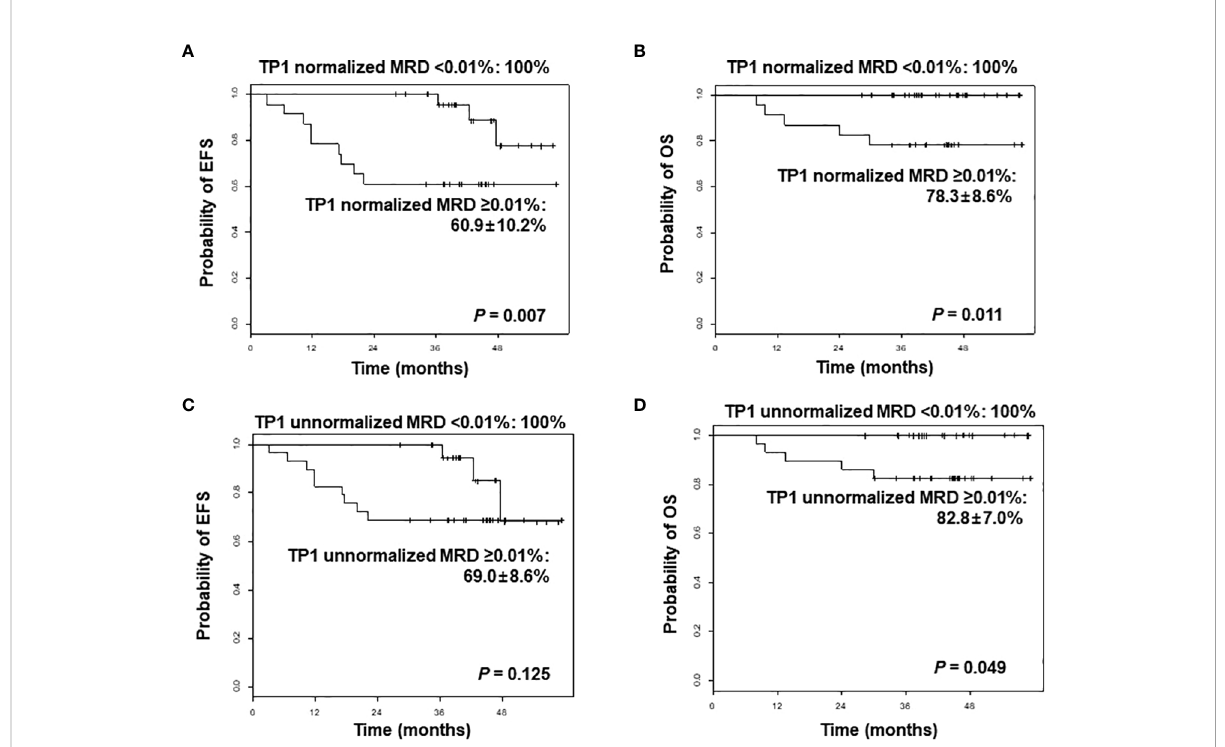
FIGURE 1 Comparison of event-free survival (EFS) and overall survival (OS) of overall patients according to normalized minimal residual disease (MRD) values (A, B) , and unnormalized MRD values (C, D) after induction, analyzed by next-generation sequencing-based immunoglobulin clonality assay. TP1, time point